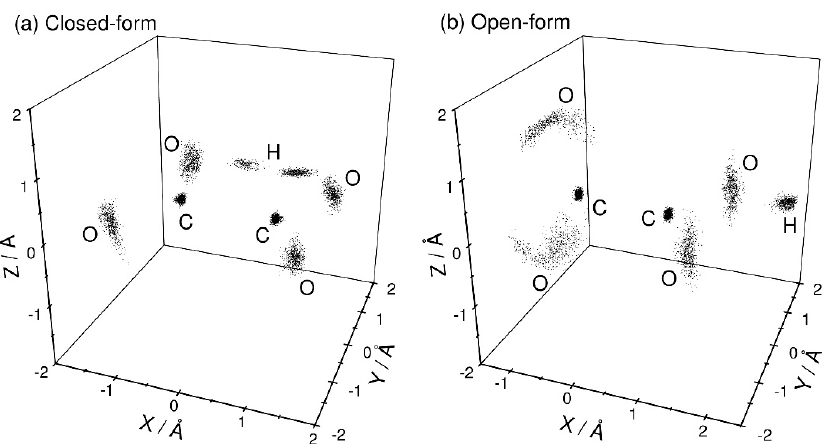
Figure 2. Three-dimensional perspective plot of the nuclear probability distribution functions of ( a ) closed-form and ( b ) open-form C 2 O 4 H − calculated from the PIMD simulations at T = 300 K. The midpoint of the two carbon atoms is fixed to the coordinate origin, and the midpoint of the two oxygen atoms is always placed on the X-axis. In addition, the hydrogen atom is placed on the X-Y plane.